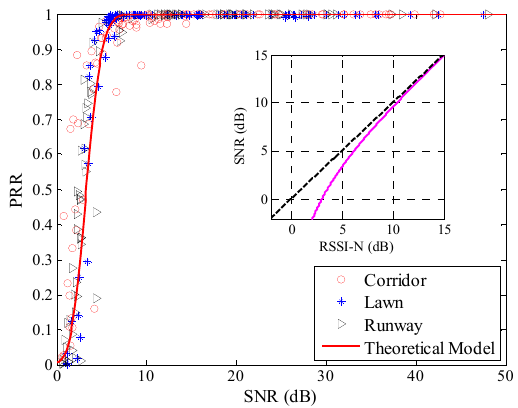
Figure 17. E ff ects of the theoretical model after correction.